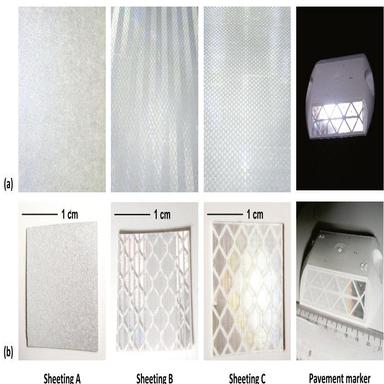
Photos of four retroreflective specimens that were tested in the simple goniometer. The products are displayed in row a, with accompanying close-up views in row b. The close-up of the pavement marker includes a centimeter ruler.